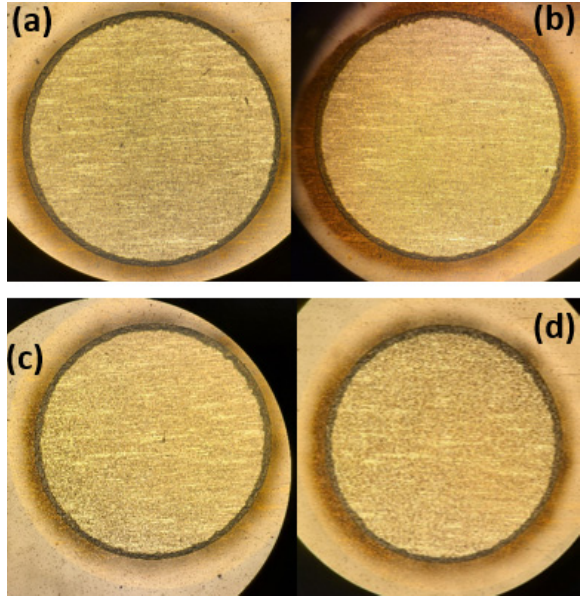
Figure 6. Visual inspection of electrodes. Selected images of electrode contacts pre- and post-electrochemical testing on the left ( a , c ) and right ( b , d ), respectively. The top images ( a , b ) are from short-term electrochemical testing, and the bottom images ( c , d ) are from long-term electrochemical testing. The contact is 3 mm, and the magnification is 5×.